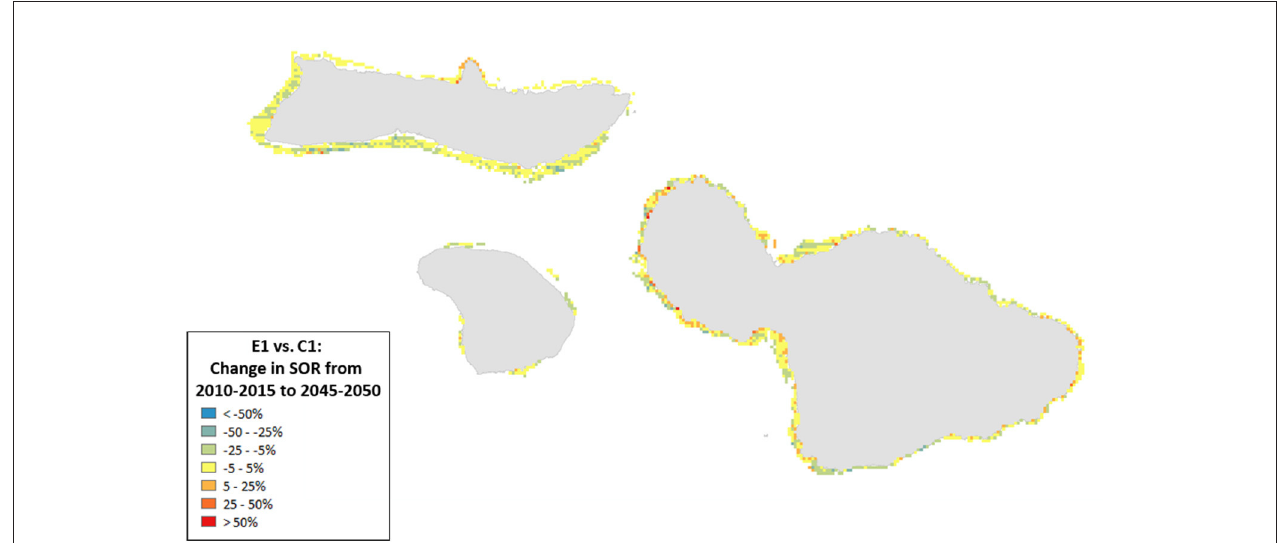
FIGURE 8 | Ratio of the change in State of the Reef (2010–2050) for scenario E1 (high sediment mitigation, 30% MPAs) compared to C1 (Current Management) under severe climate-related stressors. A value of 0 indicates no change from the outcome in 2050 under Current Management, values > 0 indicate an improvement (or, more accurately, less of a decline from the Current Management), while values < 0 indicate a worsening of the decline relative to Current Management.